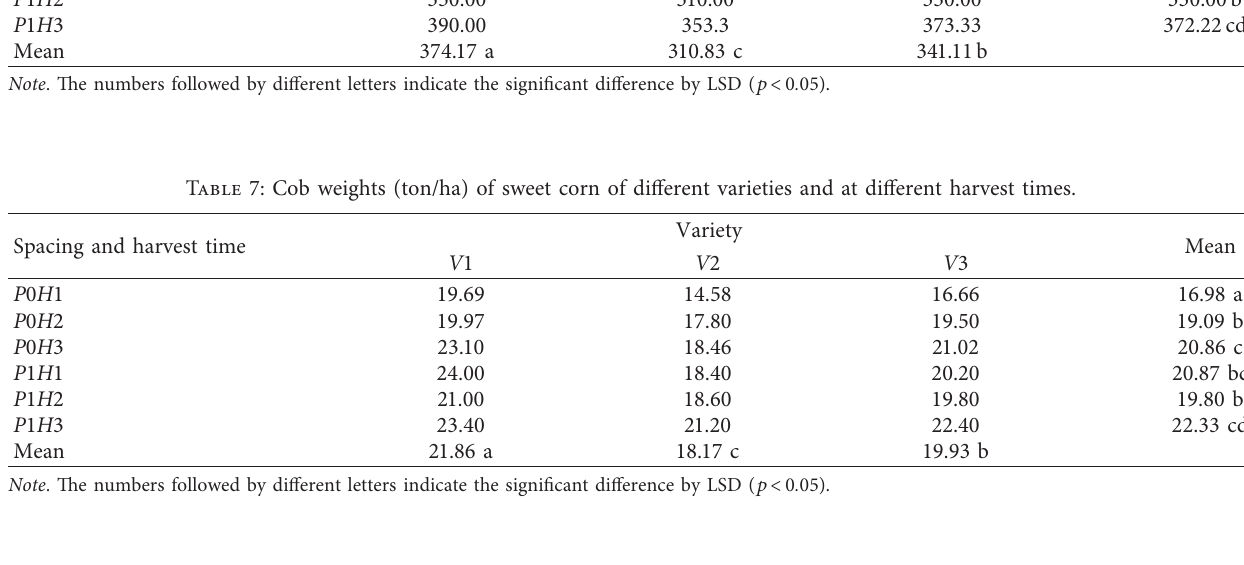
Table 8: Sweet corn content ( ° Brix) of different varieties and at different harvest